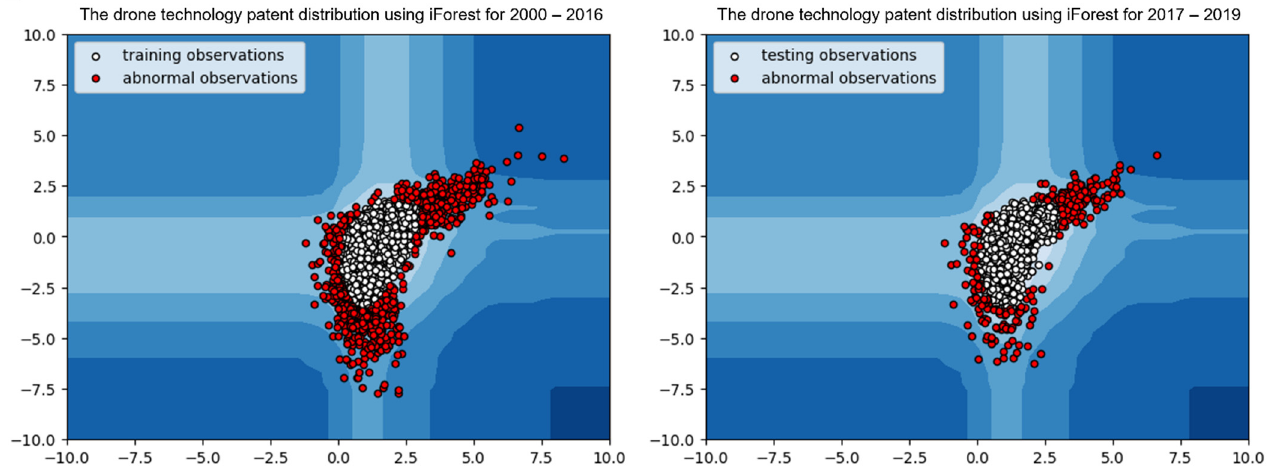
Figure 8. The result of document embedding (iForest).